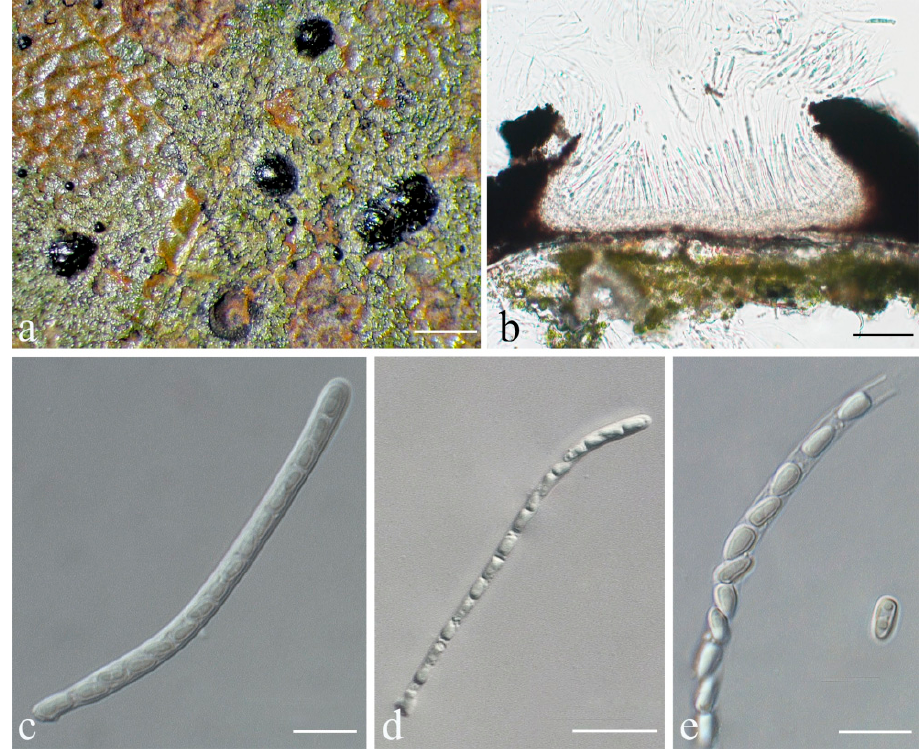
Figure 12. Strigula pseudosubtilissima sp. nov. ( a ) Thallus (holotype, HMAS–L0130553); ( b ) perithecia (holotype, HMAS–L0130553); ( c ) ascus (holotype, HMAS–L0130553); ( d ) ascus (HMAS–L0130597); ( e ) ascospores (holotype, HMAS–L0130553). Scale bars: ( a ) = 600 µ m, ( b ) = 50 µ m, ( c , e ) = 10 µ m, ( d ) = 20 µ